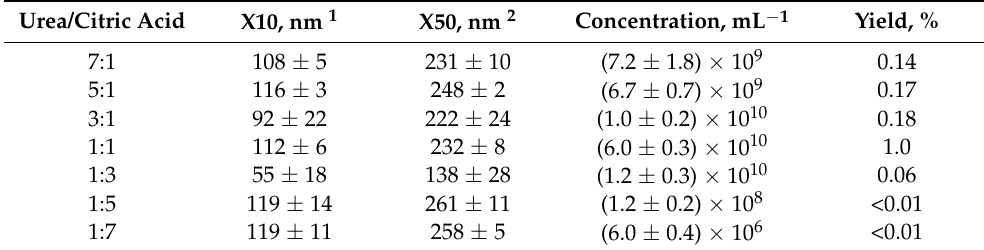
Figure 2. Appearance of the products of the solvothermal treatment of mixtures of urea or thiourea with citric acid. The purified samples are in the top rows, the dialysates are in the bottom rows. The stars mark the samples obtained at 1:1 ratio of (thio)urea to citric acid. Table 1. Particle characteristics for the purified products of the solvothermal treatment of mixtures of urea with citric acid. The data are given as value ± standard deviation. See details in the